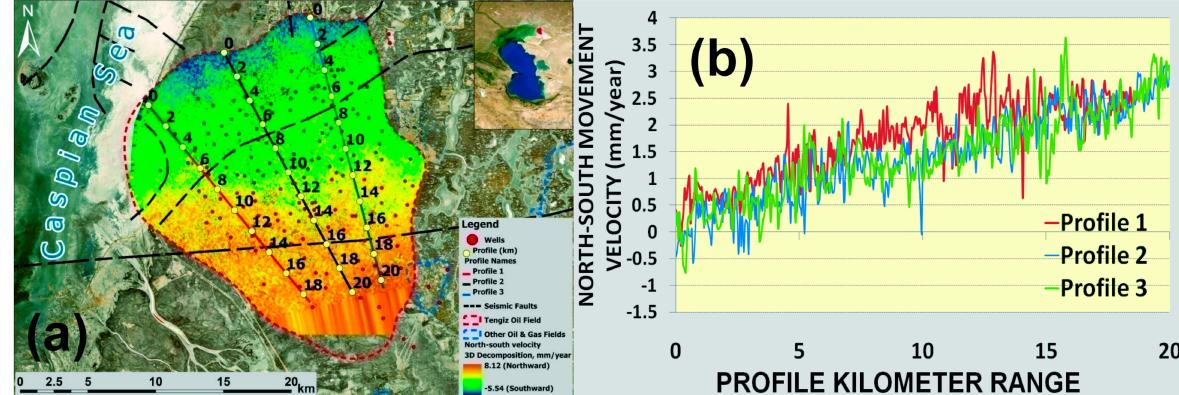
Figure 9. ( a ) North-south movement velocity derived from 3D decomposition of 2 ascending and 1 descending LOS measurements; ( b ) North-south movement velocity along profiles.